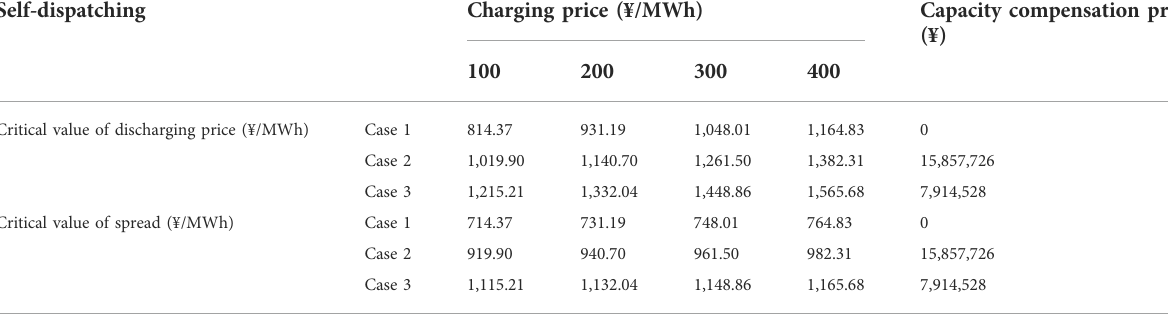
TABLE 4 Critical values of discharging price and charging-discharging spread in self-dispatching mode. Self-dispatching